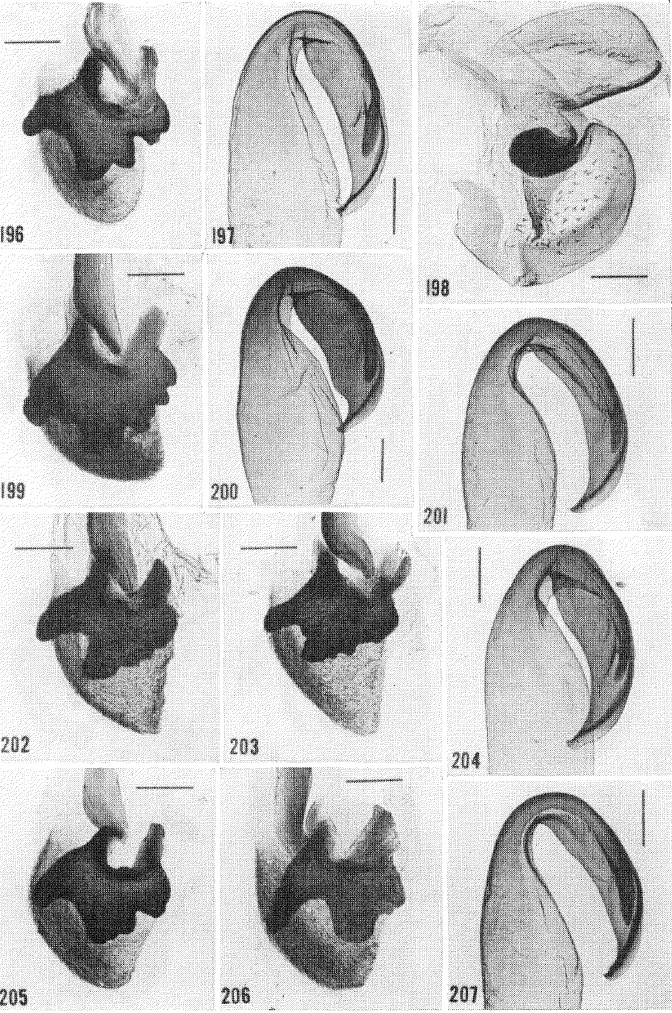
Figs. 196-207. Cockroach male genitalia. Elilamlra substrigata. 196-198. (129 USNM). Napo Santa Cecilia, Rio Aguarieo, Ecuador (det. Roth). 199-200. (46 ANSP). Villavieensio, Colombia (det. Hebard). 201-202. (68 USNM). Anabern, Colombia (det. Albuquerqu,e). 203-204. (71 USNM). Territ. Amazonas, San Fdo. Atabapo, Venezuela (det. Albuquerque). 205. (128 USNM). Napo Santa Cecilia, Rio Aguarieo, Ecuador. (det. Prineis). 206-207. (79 USNM). Territ. Amapfi, Brazil (det. Albuquerque). (scale--- 0.2